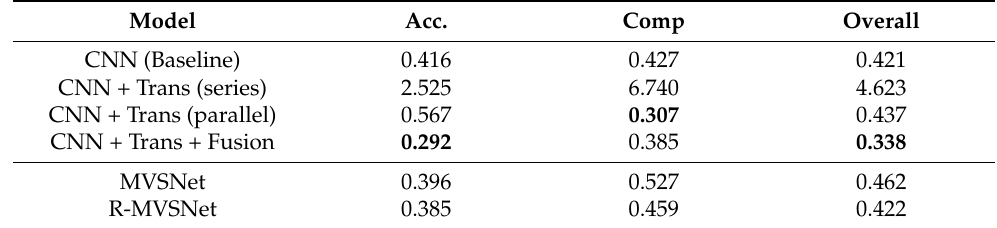
Table 3. Quantitative results with different components on DTU evaluation dataset (lower is better).